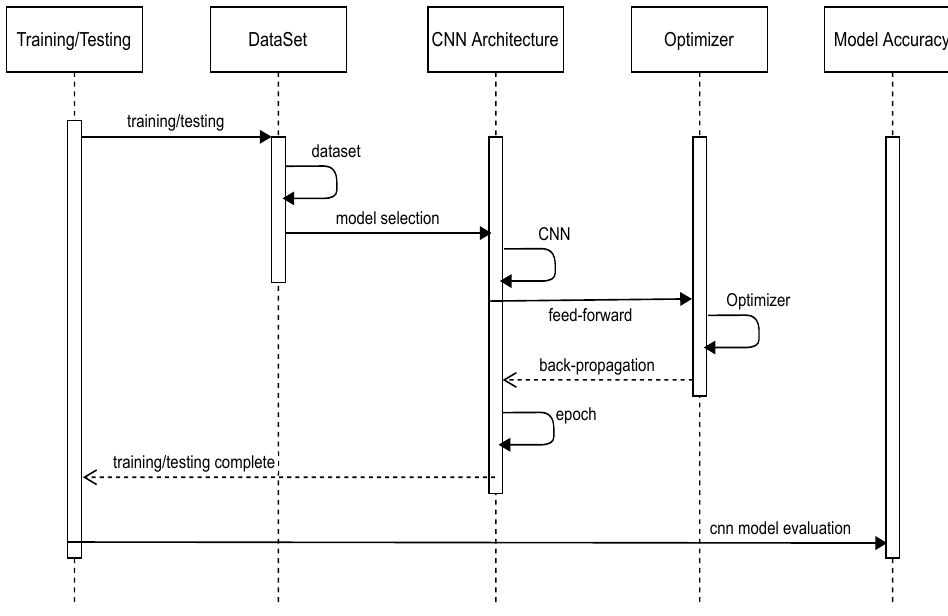
Figure 2. Sequence diagram of the proposed optimization